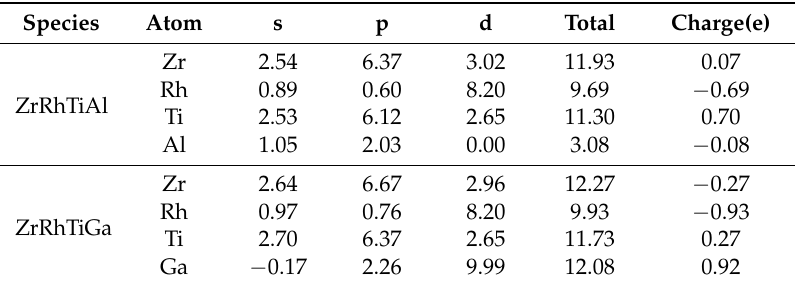
Table 2. Mulliken population analysis of ZrRhTiAl and ZrRhTiGa.